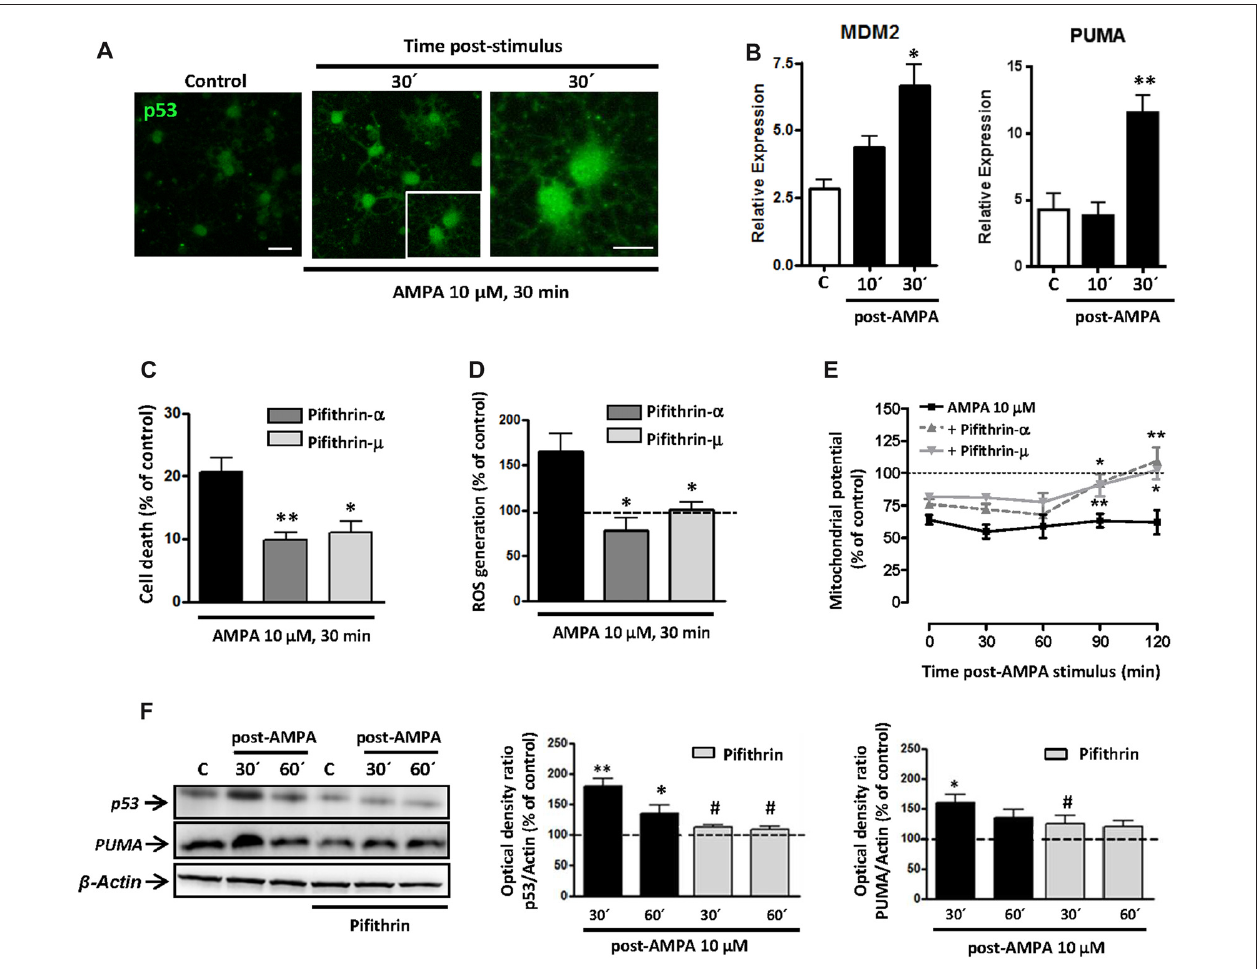
FIGURE 6 | AMPA excitotoxic insult induces p53 stabilization and transcriptional activation in oligodendrocytes, which is inhibited by pifithrin. Oligodendrocytes were exposed to 10 µ M AMPA together with 100 µ M CTZ for 30 min. (A) Immunofluorescence analysis of p53 expression. After AMPA receptor activation, at 30 min post-stimulus, cells were processed for p53 immunofluorescence using the p53 (FL-393) antibody, which recognized total p53. Exposure to AMPA triggered a notable increase in the expression of total p53 (green). Scale bar, 20 µ m (left and central images); 10 µ m (right image). (B) RT-PCR analysis for expression of p53 transcriptional targets, MDM2 and PUMA, showed a significant rise in their relative expression in cultured oligodendrocytes after AMPA receptor activation. ( n ≥ 3; ∗ p < 0.05, ∗∗ p < 0.01 respect to untreated control cells). (C) AMPA-induced excitotoxicity was significantly reduced in the presence of p53 inhibitors, pifithrin- β (20 µ M) or pifithrin- µ (1 µ M), preincubated for 1 h before the activation of AMPA receptors. ( ∗ p < 0.05, ∗∗ p < 0.01, respect to cells treated only with AMPA). (D) ROS generation triggered by activation of AMPA receptors was attenuated by p53 inhibitors. Oligodendrocytes were exposed to 10 µ M AMPA for 30 min in absence or presence of pifithrin and ROS level was immediately determined using the dye CM-DCFDA (10 µ M, Molecular Probes) and measuring the signal in a Synergy-HT fluorimeter. Results showed that levels of ROS induced by AMPA were attenuated in oligodendrocytes pretreated with both pifithrin- α or pifithrin- µ . Data represent mean ± SEM ( n = 3; ∗ p < 0.05, compared with cells treated only with agonist). (E) In addition, mitochondrial membrane potential was quantified by fluorimetry at different times after AMPA stimulus, by loading cells with dye JC-1 (3 µ M, Molecular Probes). Mitochondrial depolarization induced by excitotoxic insult was attenuated in pifithrin- α and pifithrin- µ pre-treated oligodendrocytes, as compared with cells treated only with agonist. Data are represented as mean ± SEM compared with cells treated only with AMPA for each time point analyzed ( n ≥ 3; ∗ p < 0.05; ∗∗ p < 0.01). (F) Oligodendrocytes were preincubated with pifithrin- µ (1 µ M) before AMPA receptor activation and total protein was collected 30 and 60 min later for WB analysis. The presence of p53 inhibitor pifithrin- µ during excitotoxic signals reduced p53 and PUMA accumulation induced by AMPA. The analysis of β -actin was performed as an internal load control and was used